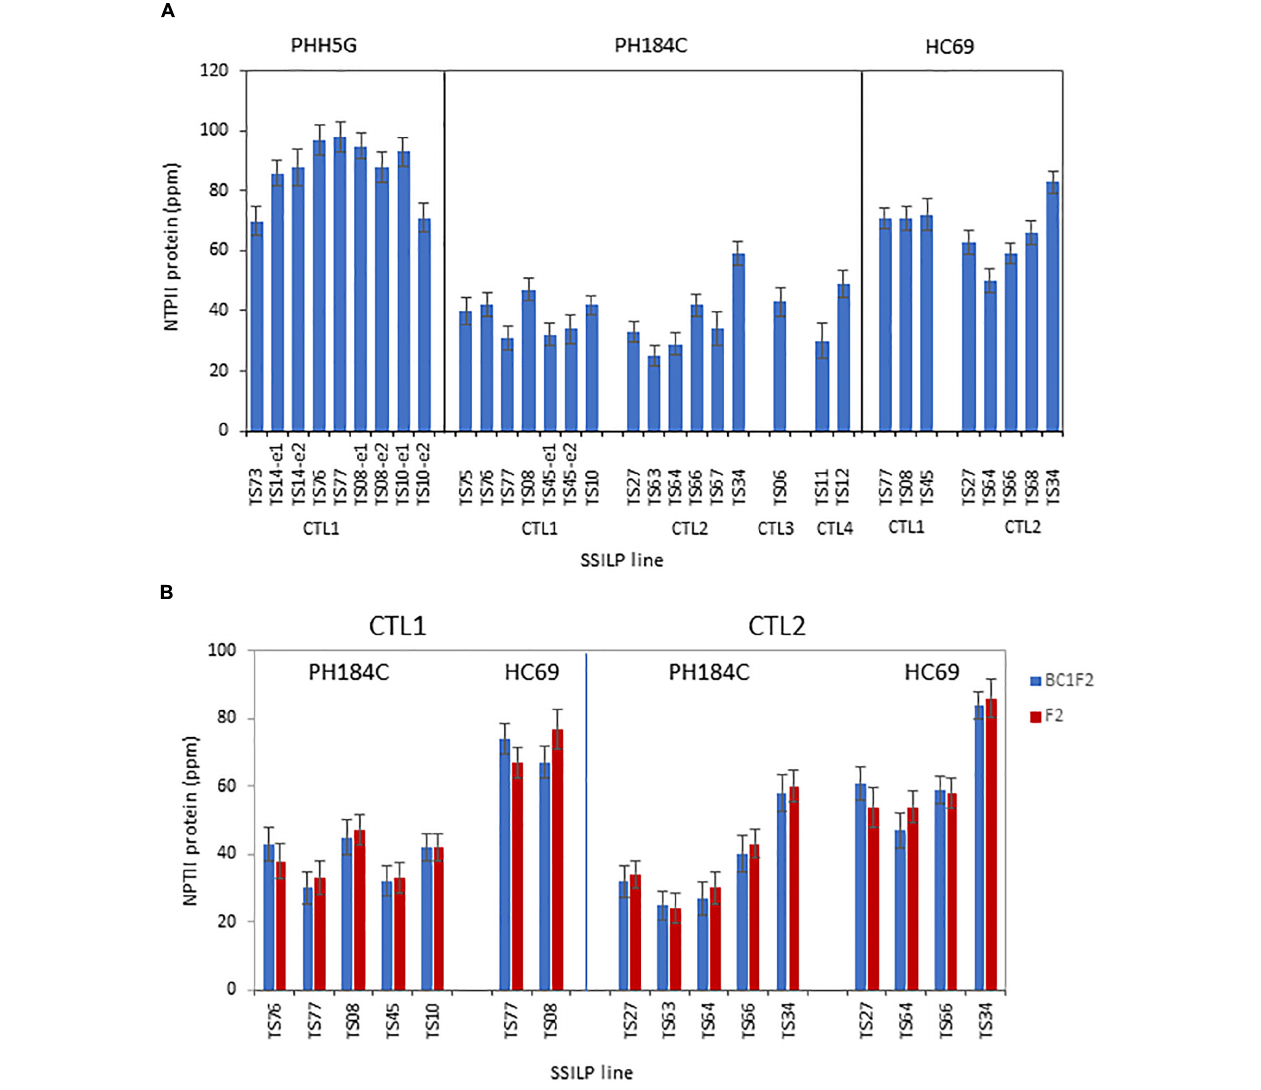
FIGURE 4 | Protein expression of the NPTII gene targeted to preselected sites at CTLs. (A) NPTII protein content in leaves of 3-week-old plants was measured using ELISA. The plants contain one copy of SSILP and were selected based on PCR genotyping results. One to two independent insertion events per target site were analyzed. Error bars, SE; N = 8–32. A total of 33 lines were measured in the study. (B) NPTII protein content in leaves of 3-week-old BC1F2 and F2 PH184C or HC69 plants was quantified using ELISA. The plants contain one copy of SSILP and were selected based on PCR genotyping results. One event per target site was analyzed. Error bars, SE; N = 7–17. A total of 16 lines were measured in the